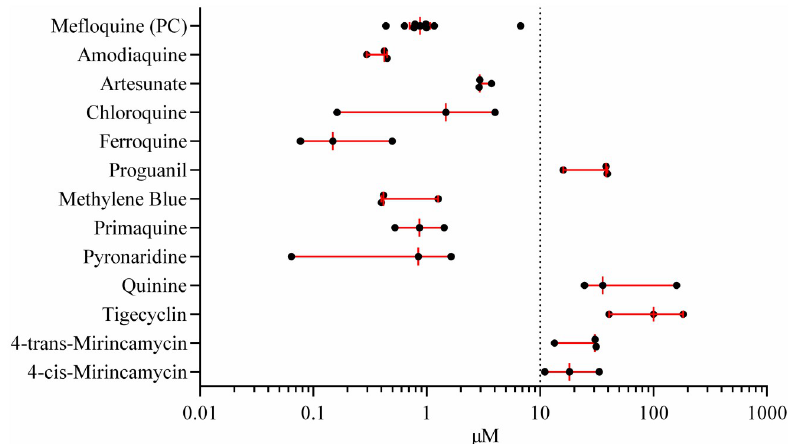
Fig 1. In vitro schistosomula assays (step 1). Dot plot of individual IC50 values of 12 drugs and mefloquine control is shown. Each compound was tested in 3 independent, in vitro schistosomula experiments (except for MQ, N = 9) and individual IC50s (filled circles) are shown. Viability of schistosomula after 7 days drug exposure was assessed by microscopy. For four drugs (atovaquone, cycloguanil, doxycycline, clindamycin) the IC50 could not be calculated as no inhibition was observed. The IC50 is given in μ M. Bar and lines indicate median IC50 and IQR. Dotted line: Threshold for drug activity is an IC50 < 10 μ M. IQR: Interquartile range.